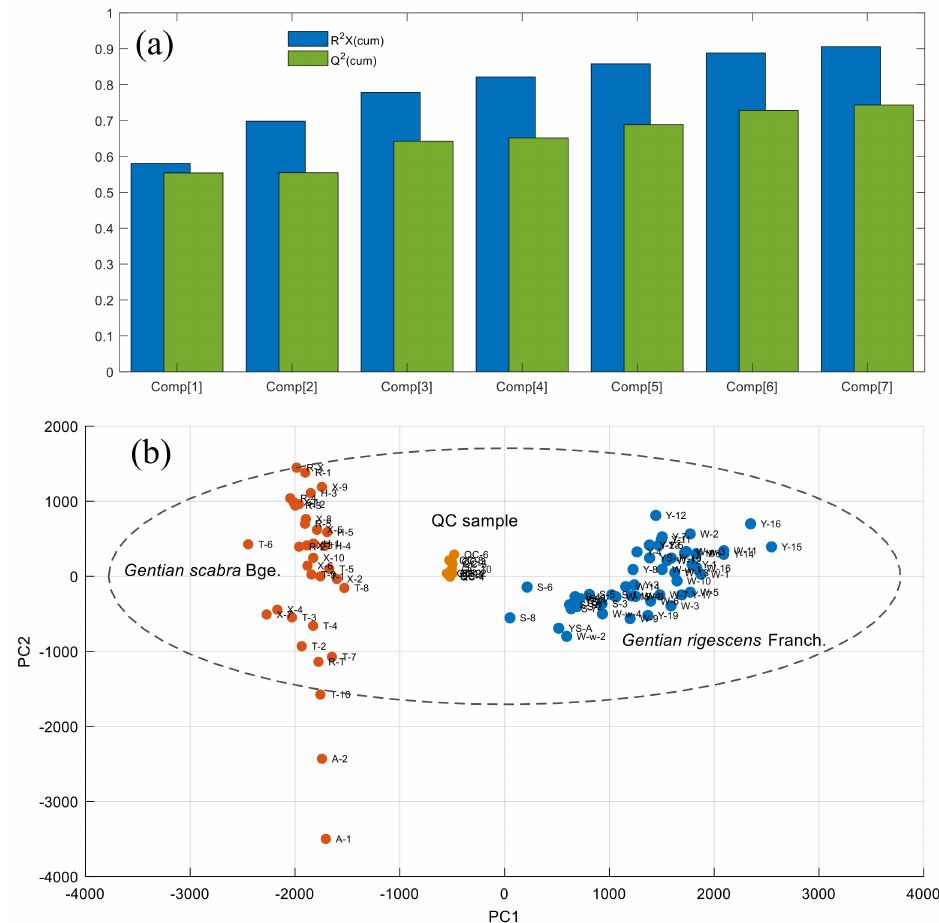
Figure 9. ( a ) Accumulated R2X and Q2 with di ff erent numbers of PCs. ( b ) score plot of PCA-X model for data visualization and experimental stability evaluation of two Gentiana species and QC